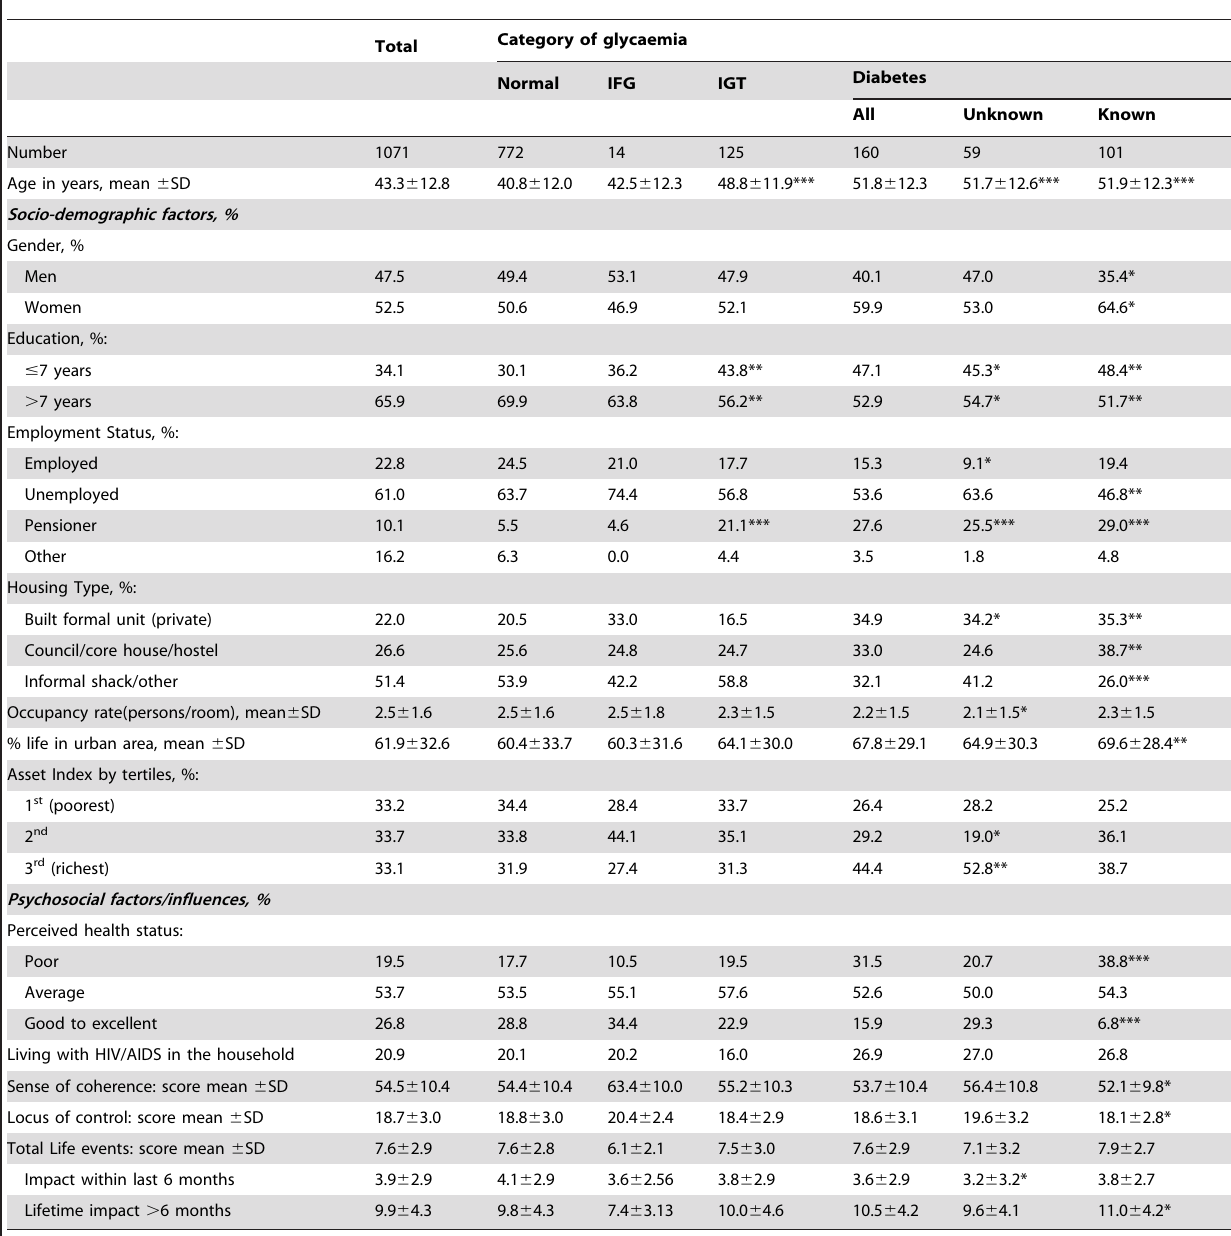
Table 1. Socio-demographic and psychosocial factors presented by glycaemic categories based on 1998 WHO criteria (n=1071) a .